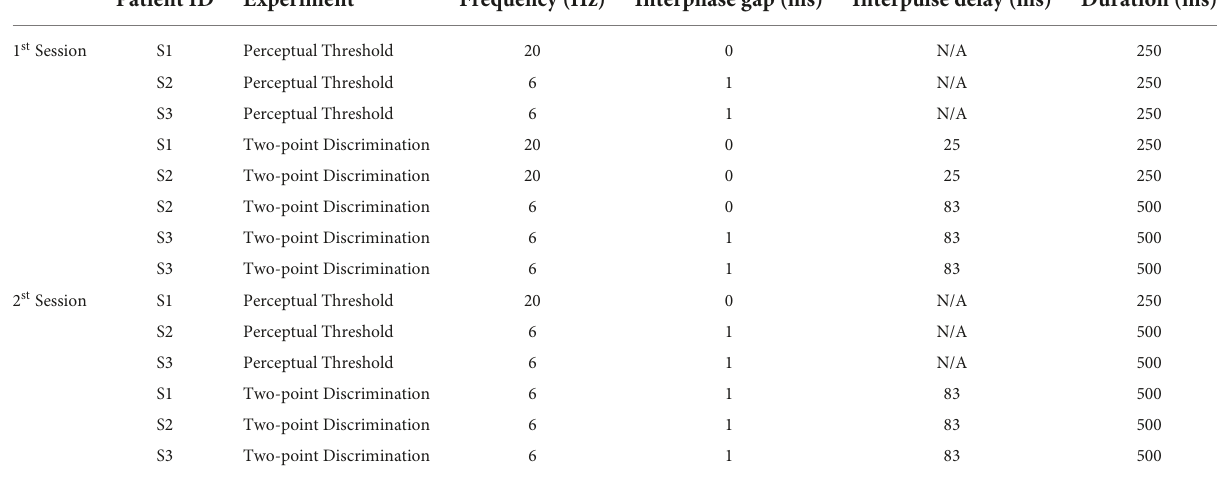
TABLE 2 Stimulation protocol and parameters for all experiments.